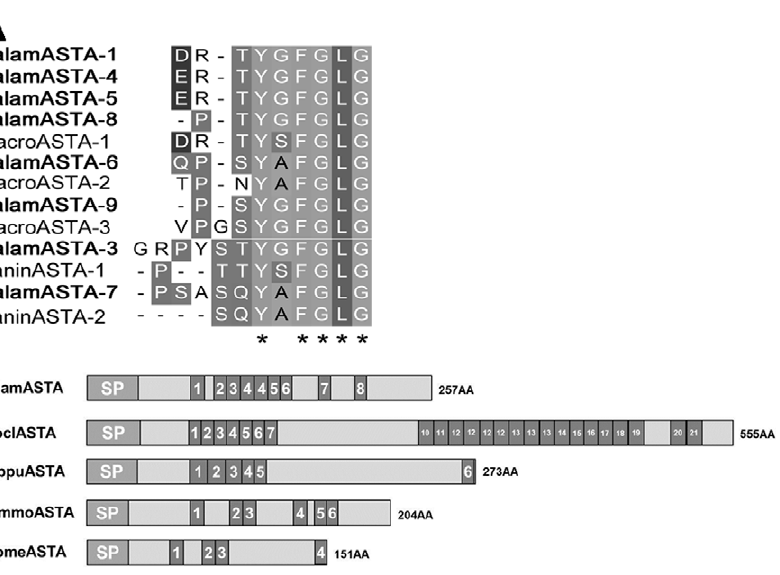
Figure 7. Sequence comparison of barnacle A-type allatostatin with homologs in arthropods. Decapod ASTAs are from Macrobrachium rosenbergii Q1AHE3, Panulirus interruptus A6BL33 and Procambarus clarkii Q3LI53; insect ASTAs are from Bombyx mori NP_001037036, Drosophila melanogaster AAF97792. Asterisk ‘‘*’’ represents typical motif residues of ASTA peptide.